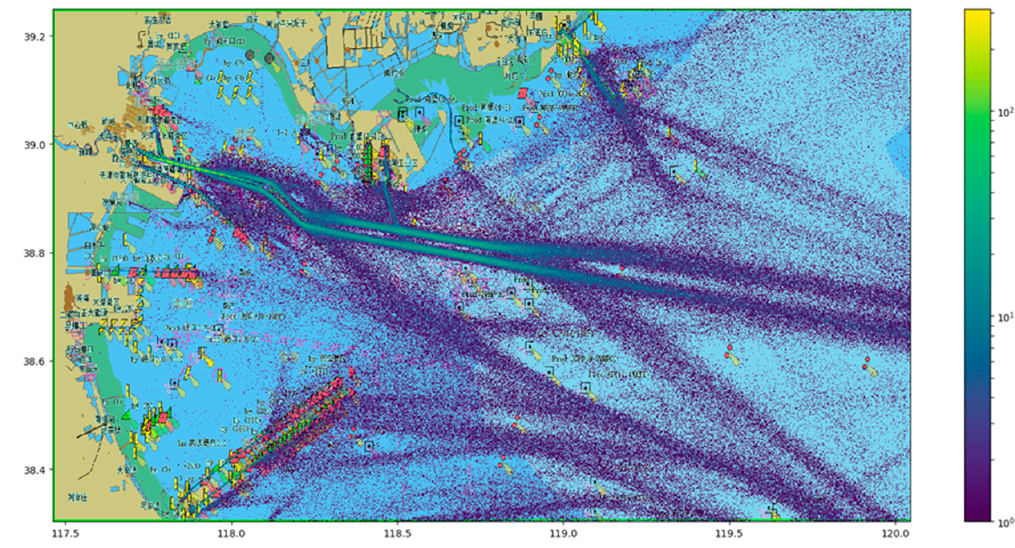
Figure 7. After AIS data compression.